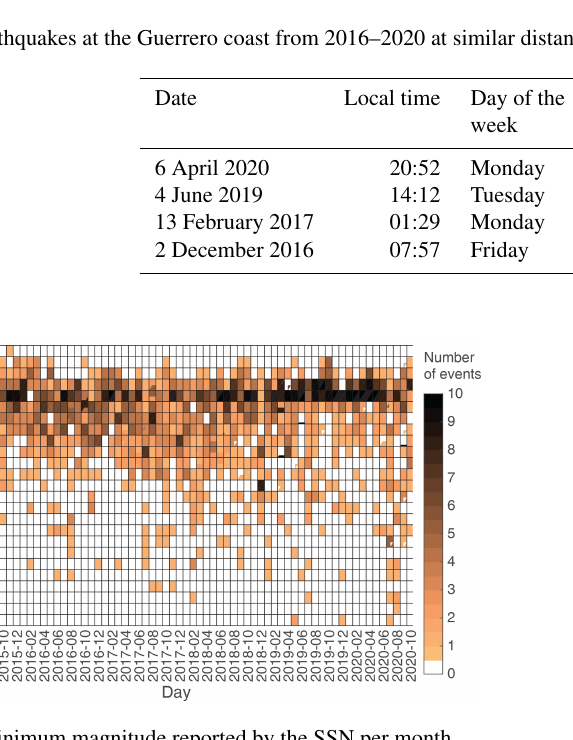
Figure 5. Minimum magnitude reported by the SSN per month.